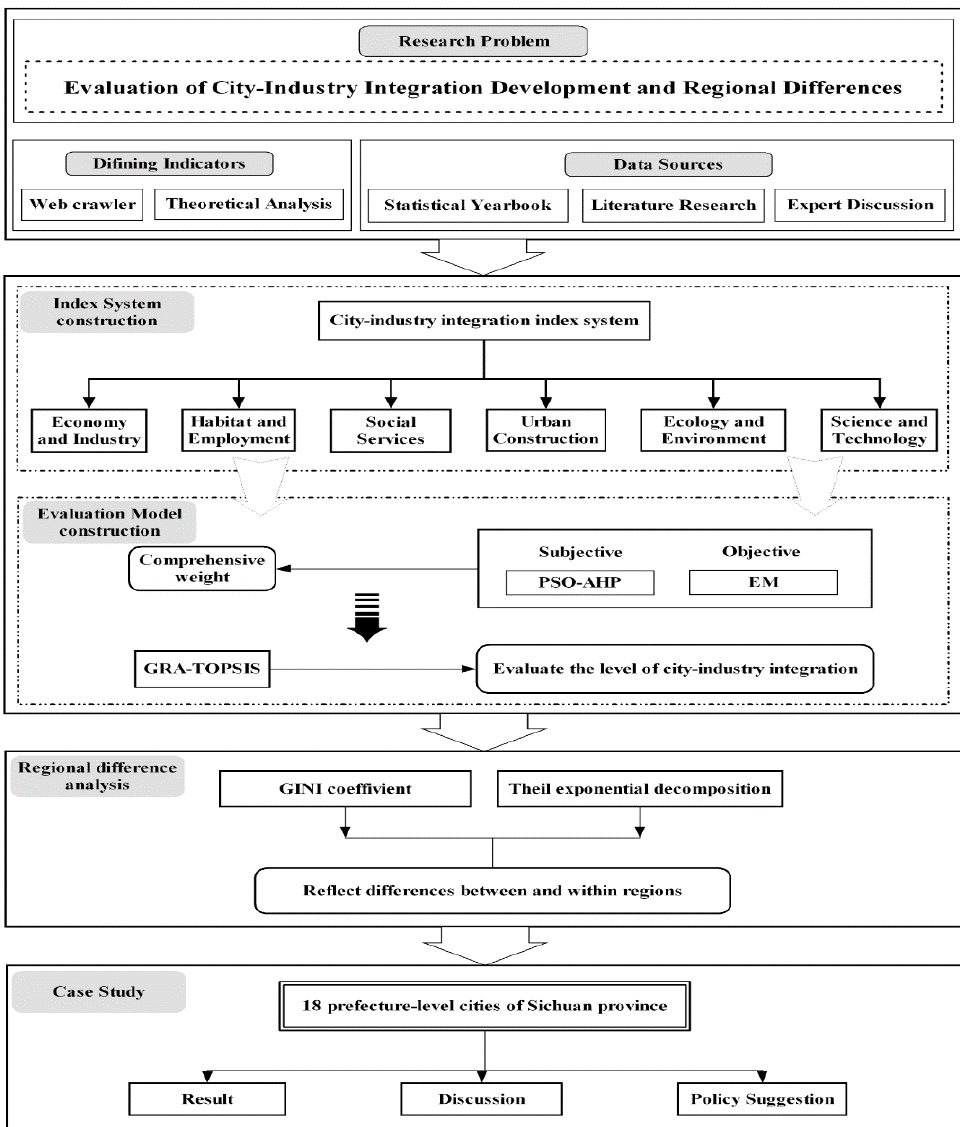
Figure 1. The research framework.